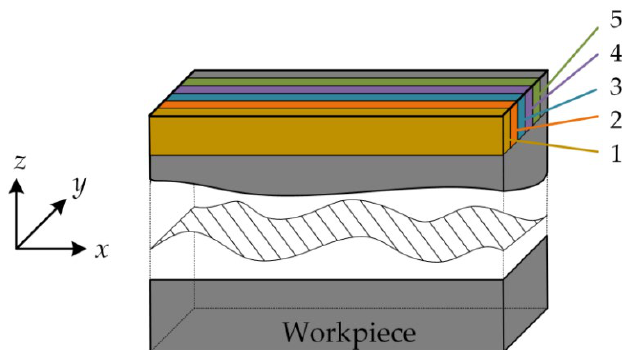
Figure 10. Material removal patterns in milling.